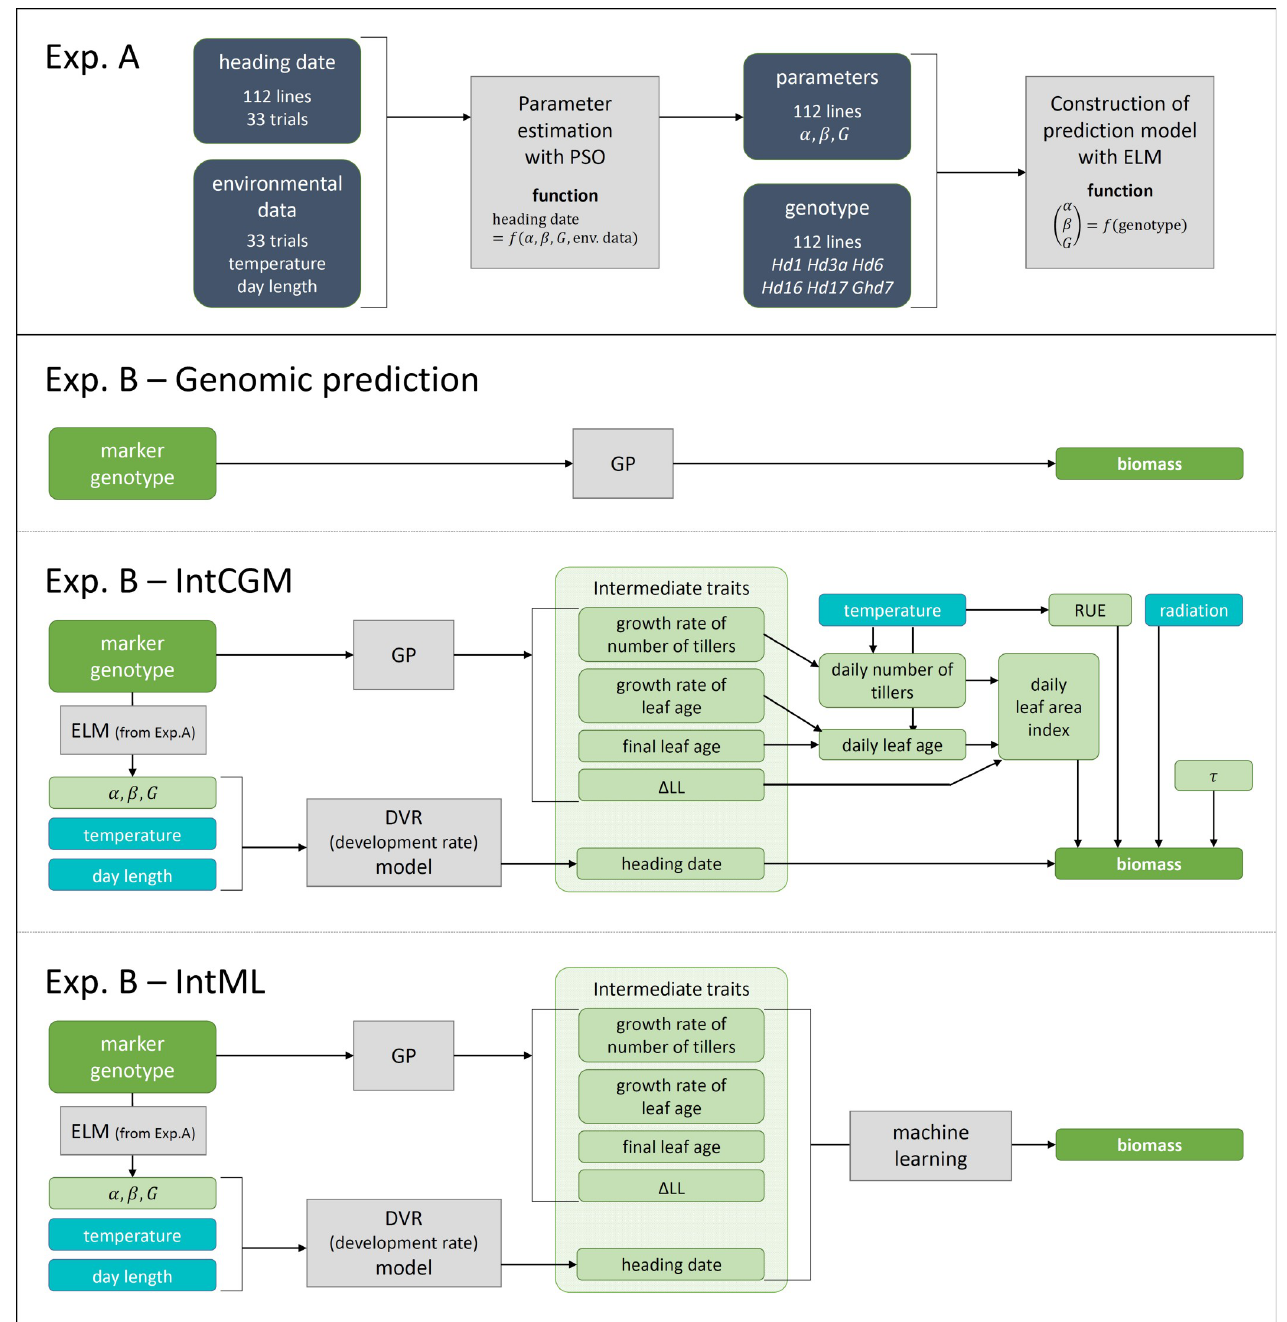
Fig 2. Flow chart of model structures. Experiment A: Process for estimating values of three parameters ( α , β , G) related to heading date. Multi-environment trial data of heading date of 112 lines were used to model the relationship between parameter values and marker genotypes of heading-date-related genes using Extreme Learning Machine (ELM). Experiment B: Structure of conventional genomic prediction (GP), integrated CGM (IntCGM), and integrated machine- learning (IntML) models. https://doi.org/10.1371/journal.pone.0233951.g002 the values of α , β ,G of the RILs by using the ELM prediction model (Experiment B in Fig 2). The marker genotypes of the heading-date–related genes of the RILs were assumed to be the same as those of the SNP nearest to the genes, and were used as inputs of the ELM model.